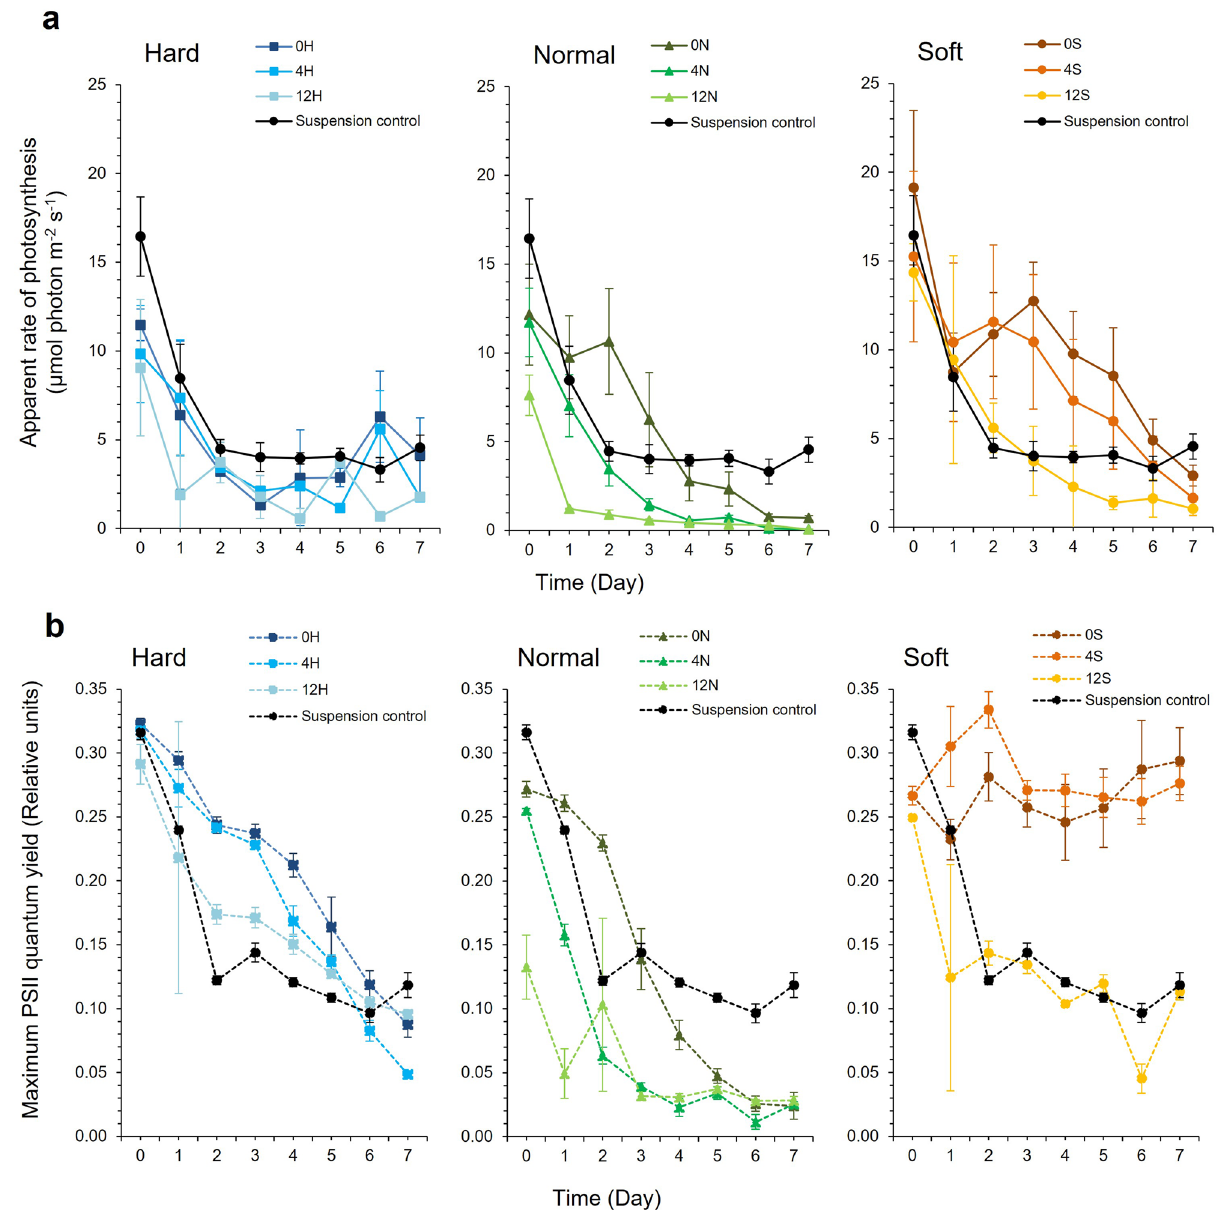
Figure 3. ( a ) Apparent rate of photosynthesis (PS) and ( b ) Maximum PSII quantum yield (F v /F m ) of Synechococcus elongatus CCAP 1479/1A in response to latex formulation compared to suspension culture controls. ‘Hard’ (H) latex had a styrene to butyl acrylate ratio of 1:3, ‘normal’ (N) was 1:1, and ‘soft’ (S) was 3:1. The preceding number in the latex code corresponds to the Texanol content. (Mean ± StDev; n =